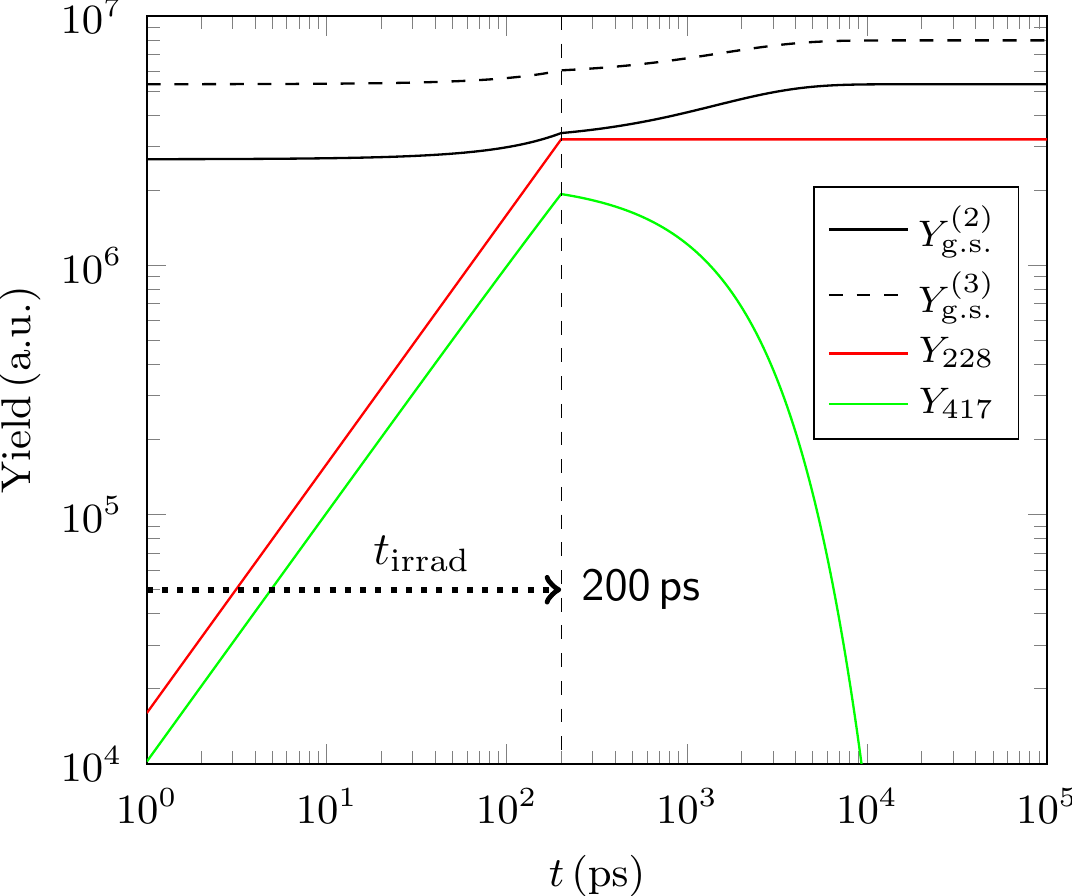
Figure 2. Calculated yields Y 228 (red) and Y 417 (green) as function of time t per proton pulse with t irrad = 200ps (vertical dashed line) and 4.988MeV E p ≤ ≤ 5.820 MeV. The accumulated yields Y g.s. for the ground state are superimposed for the 2 nd (solid black) and 3 rd (dashed black) consecutive proton pulses. We assume those pulses to impact on the same target volume in the secondary production target. Note the influence of the direct feeding from the 417 keV level to the ground state from the non-linear enhancement of Y g.s. during t irrad . A time interval of 100 s between the 2 nd and 3 rd pulse was assumed.